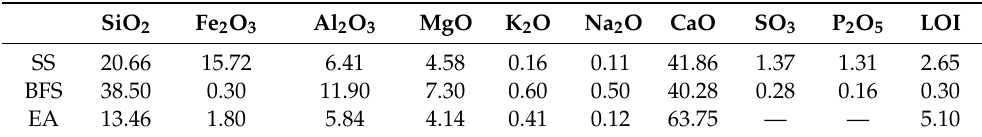
Table 4. Chemical composition of powder (wt.%).